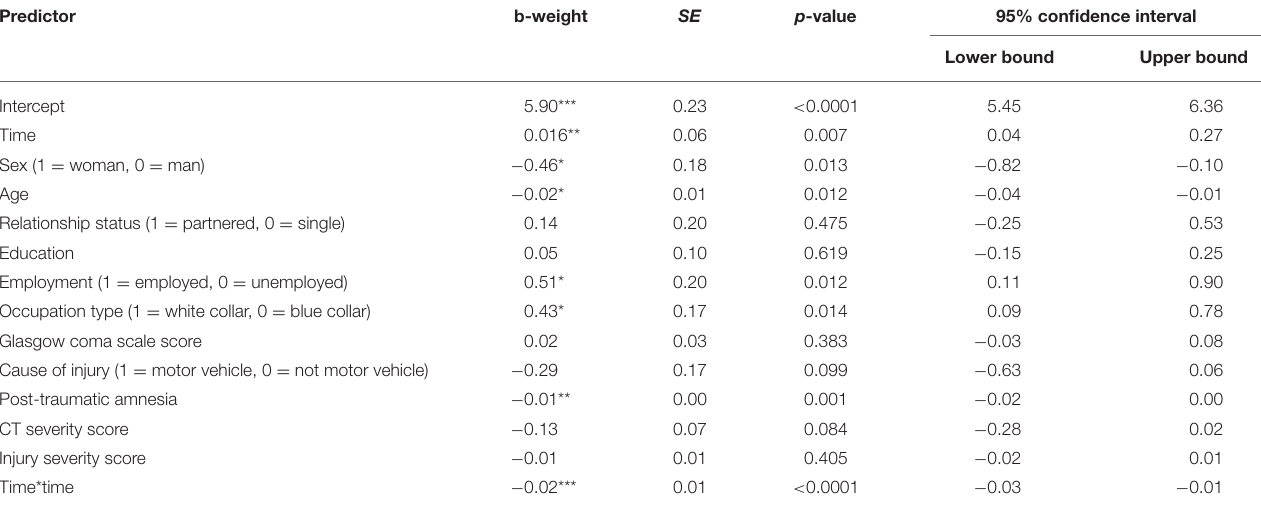
TABLE 4 | Socio-demographic and injury predictors of GOSE trajectories across 1, 2, 5, and 10 years after injury. Predictor